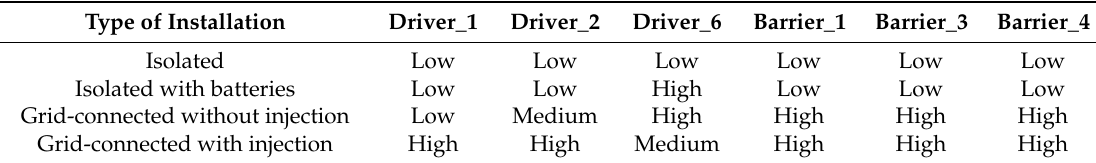
Table 6. Weight matrix (own